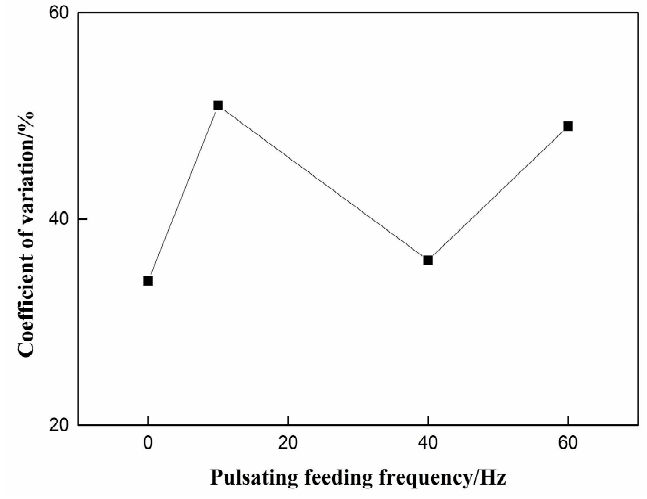
ff ect of pulsating feeding frequency on coe ffi cient of Figure 7. Effect of pulsating feeding frequency on coefficient of variation. Figure 7. E Figure 7. Effect of pulsating feeding frequency on coefficient of variation.